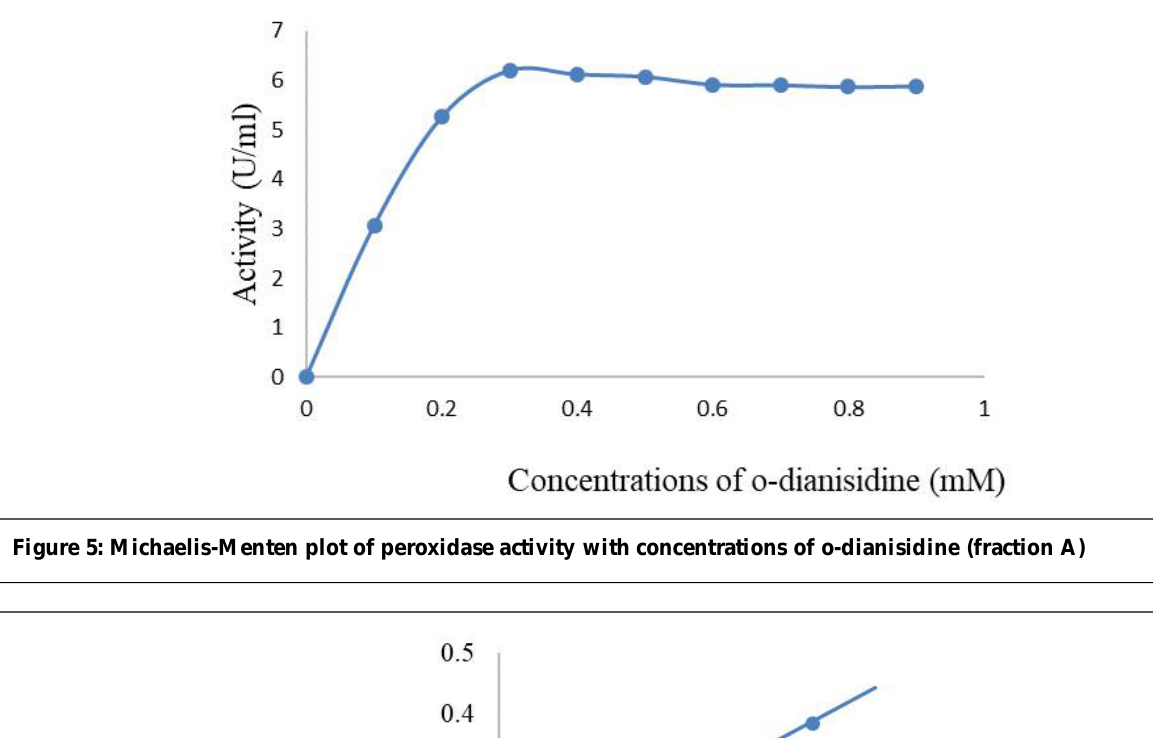
Figure 5: Michaelis-Menten plot of peroxidase activity with concentrations of o-dianisidine (fraction A)